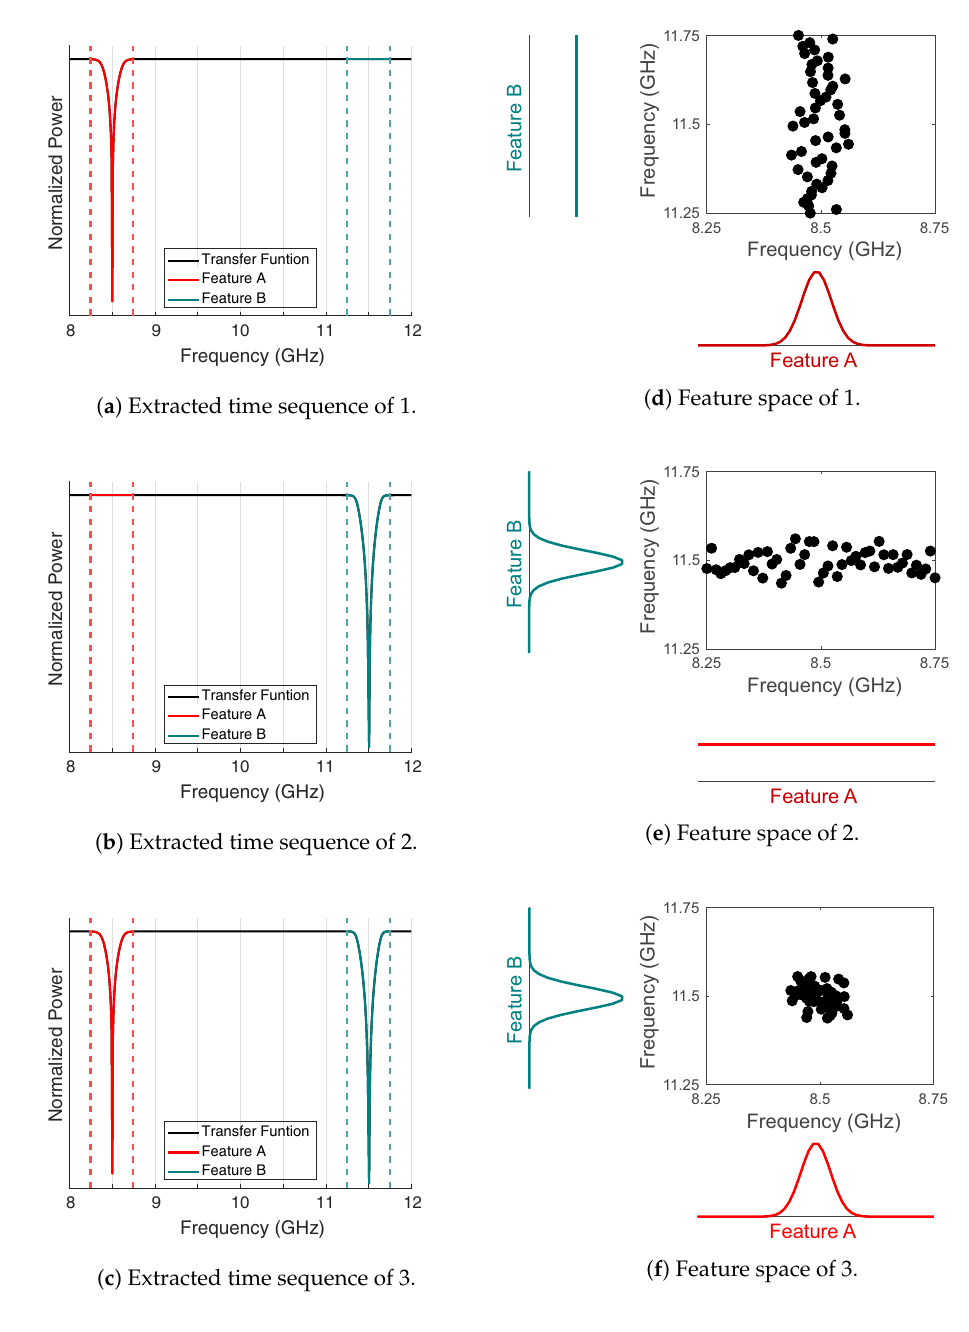
Figure 4. ( a – c ) Extracted time sequence and ( d – f ) associated feature space The absolute values of the power levels of the features A and B are then converted into a probability of occurrence of the respective frequency points. Thus, a notch in the feature space is determined by the distribution of its cumulative quantity. As can be seen in Figure 4d–f, the distribution of the data in the feature space is a direct measure of